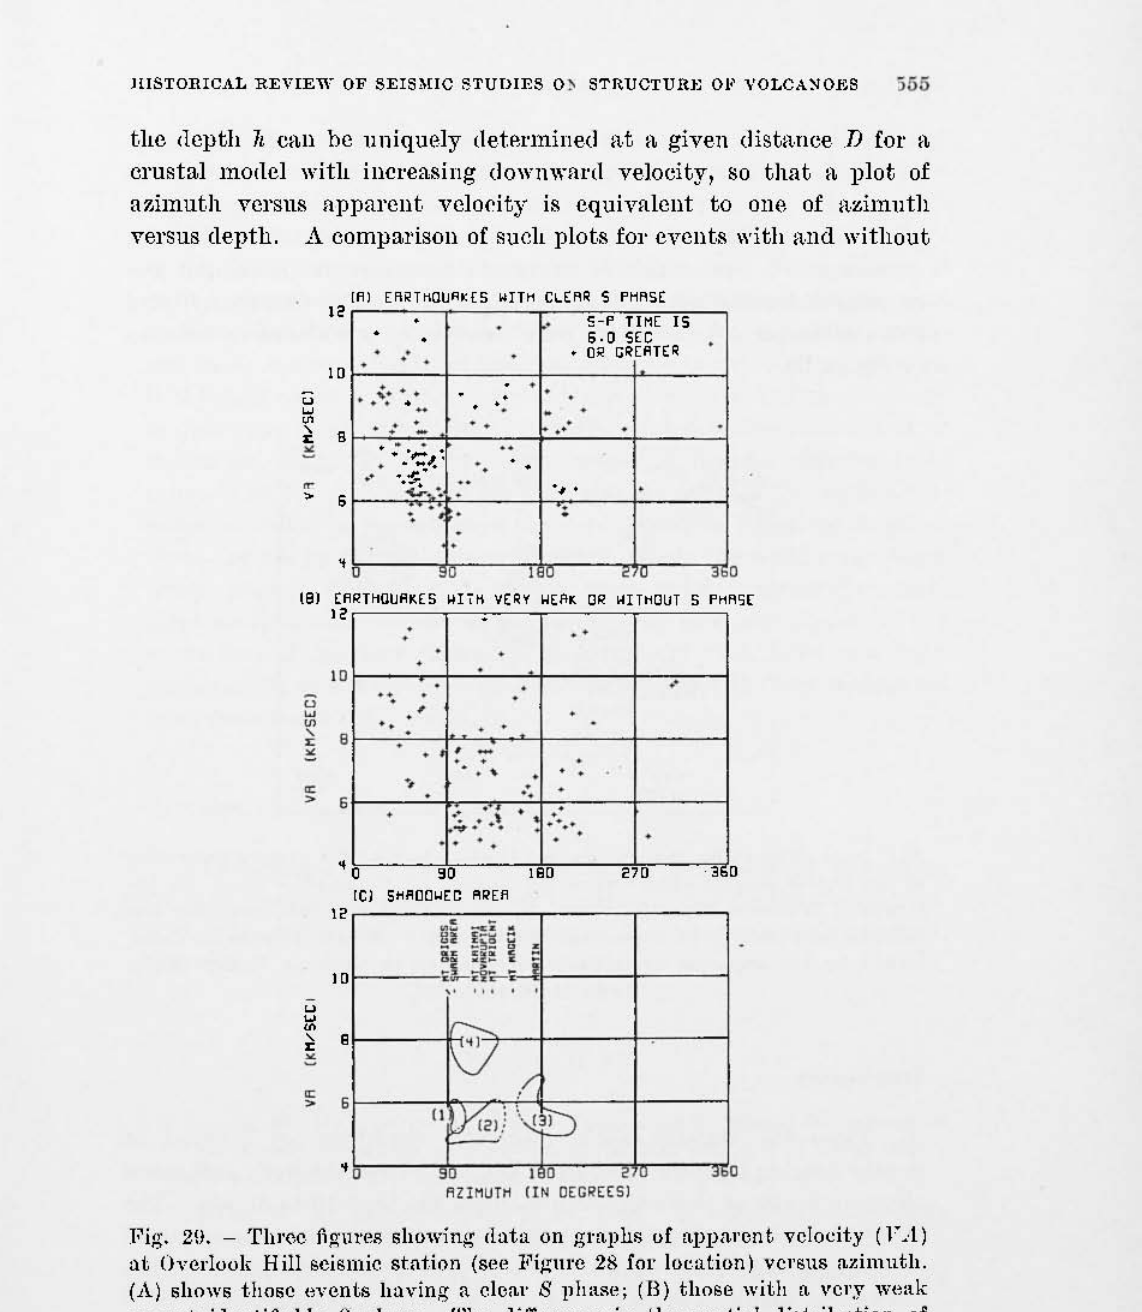
Fig. 2U. - 'l'hl'(\(! n,!l.'Ul'es showing data on gnt!Jhs or appal'cnt vclocity (FA) at Ovcrlook Hill SCiSlllic stntion (see l<'igl1\'c 28 fol' loeation) VCl'SUS azimuth. (A) shows thosc evcnts having a c1cal' S llhase; (B) those with a VCl'.y weak 01' not idcntinahlc S phase. 'l'he ùiITCl'cncc in thc sllatiaI llistribution of thc cvcnts in (A) and (E) is eonsidel'cd signiflcant. (C) shows spcdfie IIoIllains in which distinctivc diffCl'cuees in thc Ilistl'ibution arc obscl'vcd Lfl'om :'Ila· tllmoto